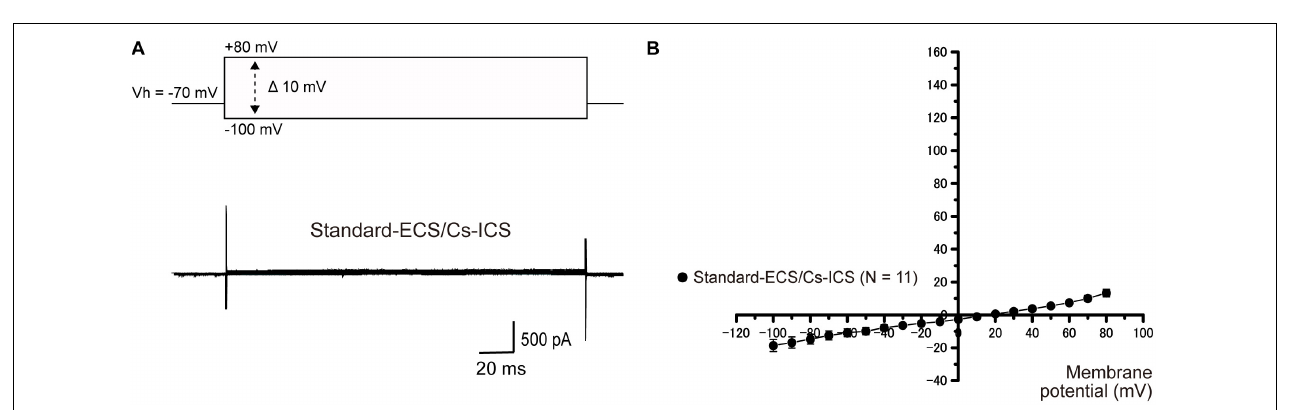
FIGURE 2 | Effect of Cs + on outward currents . (A) In the standard-ECS and Cs-ICS, outward currents almost disappeared (lower traces), compared to them recorded with standard-ICS ( Figure 1 ). The currents were elicited by applying voltage in 10 mV increments from –100 mV to +80 mV at a holding potential (Vh) of –70 mV (400 ms in duration). (B) Current-voltage (I-V) relationships of the currents recorded from the Cs-ICS and standard-ICS. Each point represents the mean ± SE current densities of 11 cells.